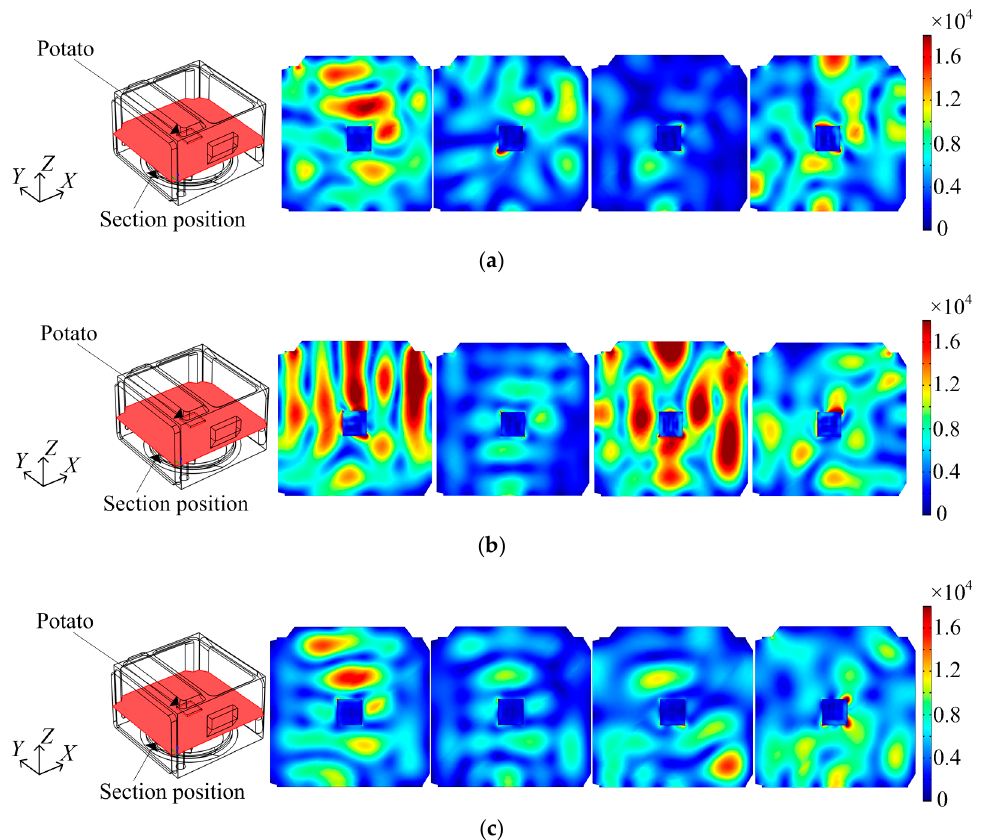
Figure 8. Electric field distributions of horizontal sections ( Z height: 0.0685 m) of the microwave oven with the turntable rotation angles of 0°, 90°, 180°, and 270° (unit: V/m): ( a ) PE-aluminum turntable; ( b ) PE-alumina turntable; and ( c ) alumina-aluminum turntable.